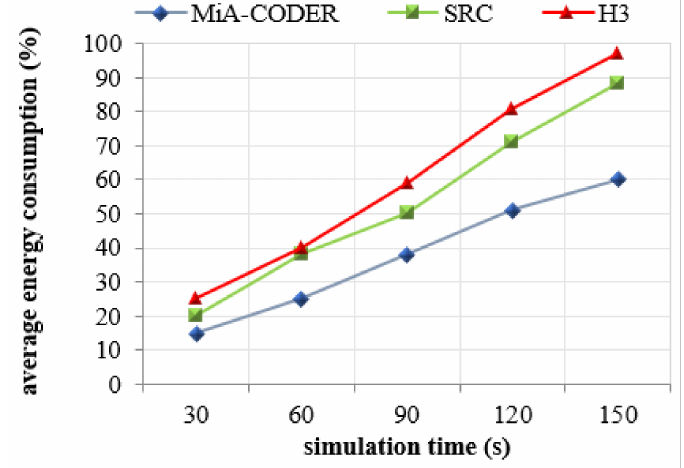
Figure 8. Simulation time vs. average energy